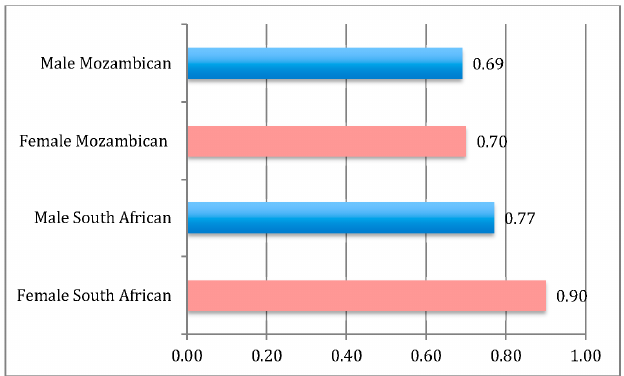
Figure 2. Predicted probability of receiving the pension by gender and nationality, Agincourt HDSS 2010; N = 4915. Figure derived from Model 3 in Table 3, with all variables but Female and South African set at their means.